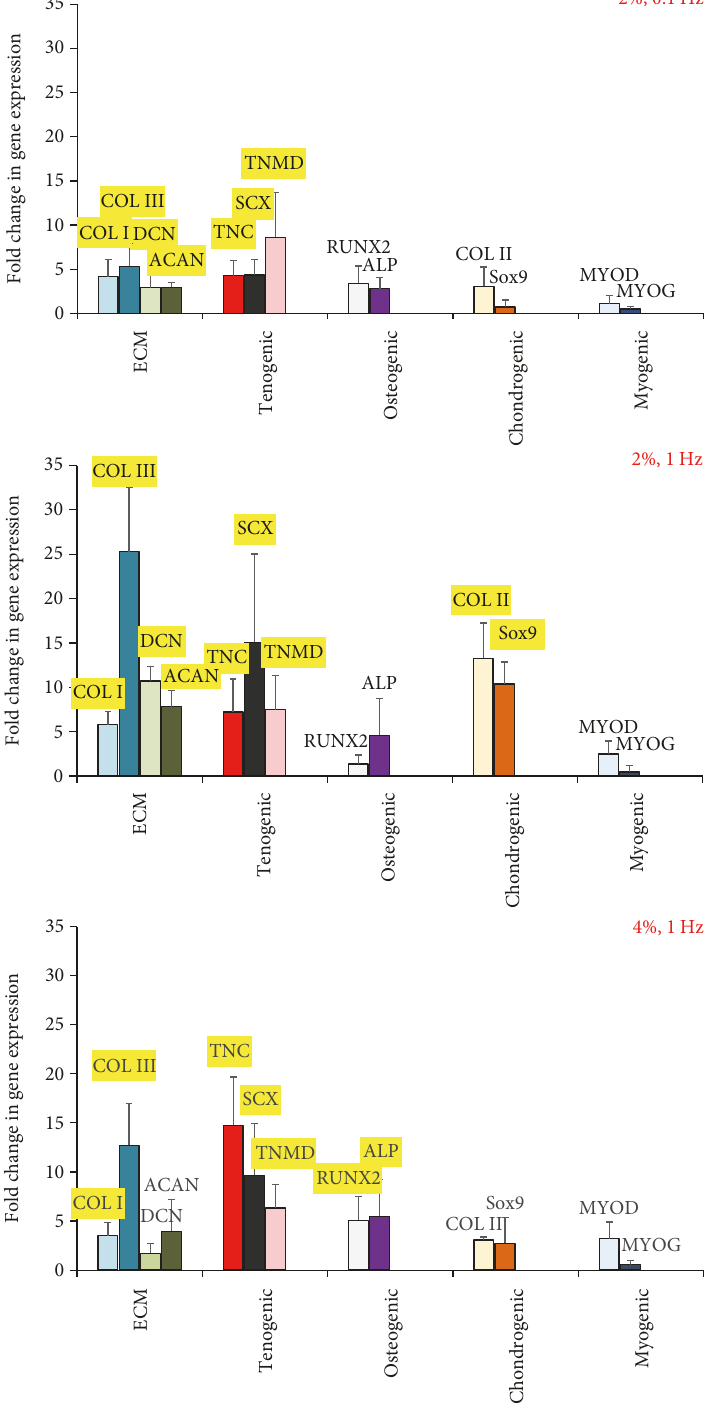
Figure 10: E ff ect of uniaxial tensile loading on ASC di ff erentiation within collagen 3D sca ff olds. Gene expression pro fi le of ECM, tenogenic, osteogenic, chondrogenic, and myogenic markers mapped for samples loaded at 2% strain at 0.1Hz, 2% strain at 1Hz, and 4% strain at 1Hz. Genes highlighted in yellow indicate statistically higher expressions when compared to nonloaded samples ( p < 0 05